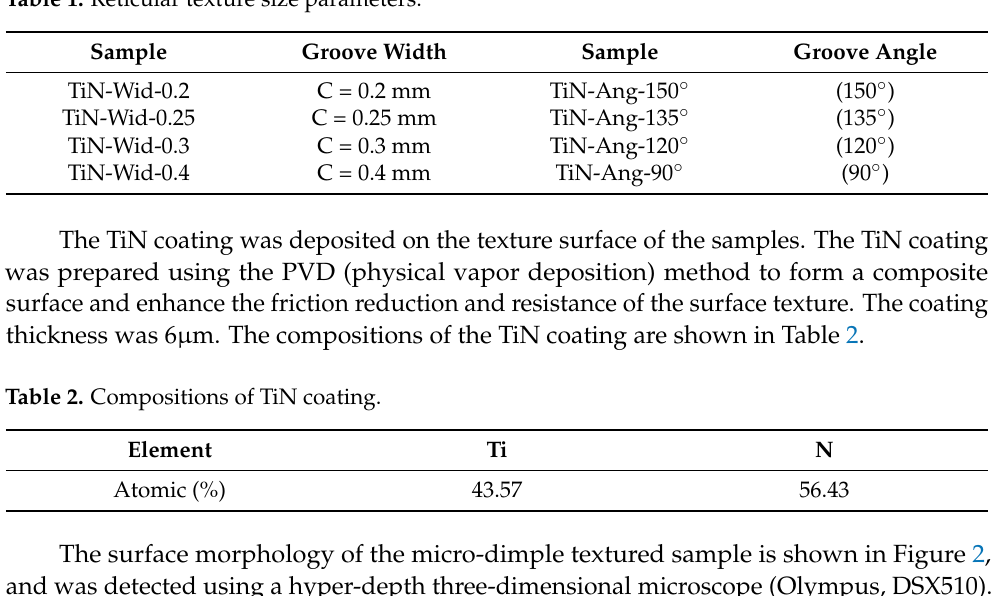
Figure 2. Morphology of the reticular texture.